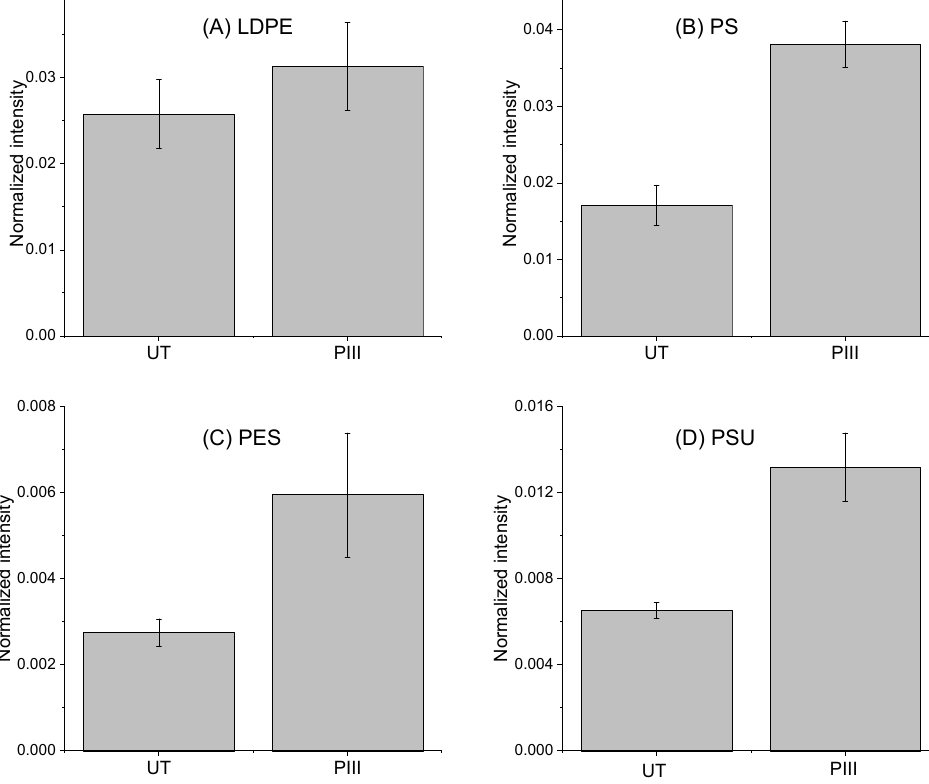
Figure 7. Comparison of protein intensity calculated from amide I and amide II peaks of FTIR spectra of untreated (UT) and PIII-treated (PIII) polymers: ( A ) LDPE; ( B ) PS; ( C ) PES and ( D ) PSU.